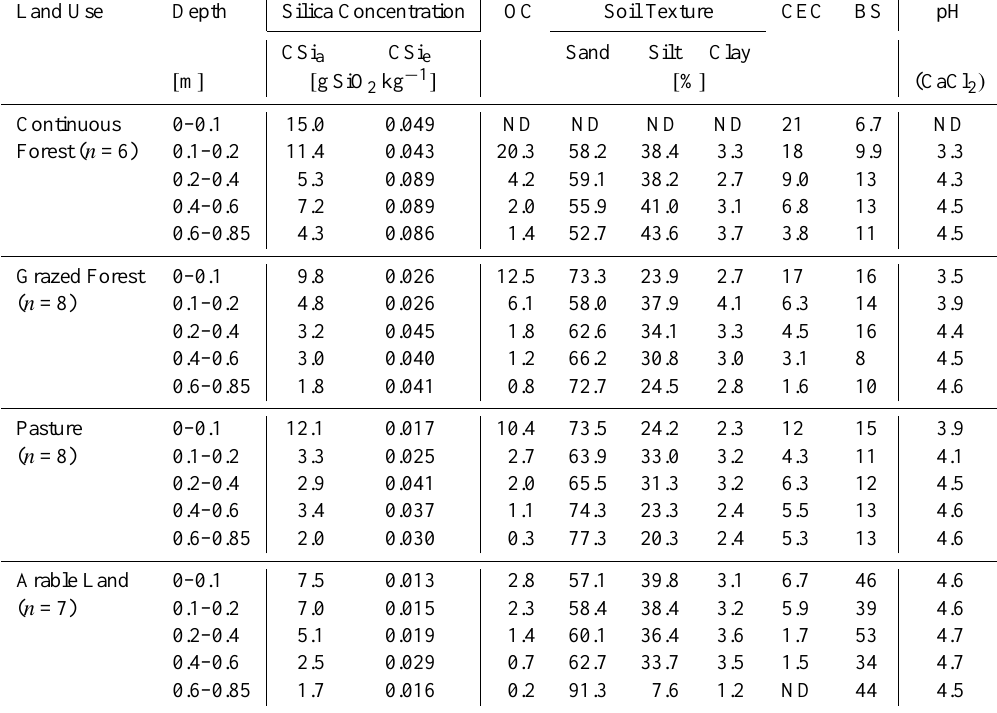
Table 1. Physical and chemical soil properties of the studied soils (ND=No Data). Land Use Depth Silica Concentration OC Soil Texture